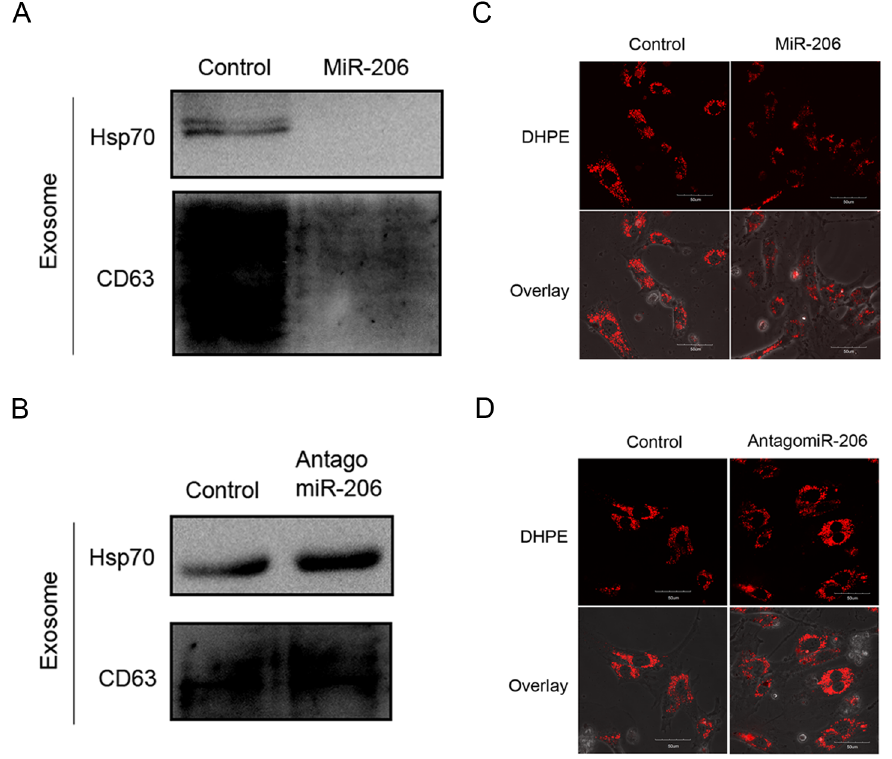
Fig 5. MiR-206 reduces HUVEC exosome production. (A, B) Western blot analysis of Hsp70 and CD63 expression in secreted exosomes from HUVECs transiently transfected with miR-206 (A) or antagomiR-206 (B). (C, D) DHPE staining of intracellular MVBs in HUVECs assayed by confocal microscopy at 600×